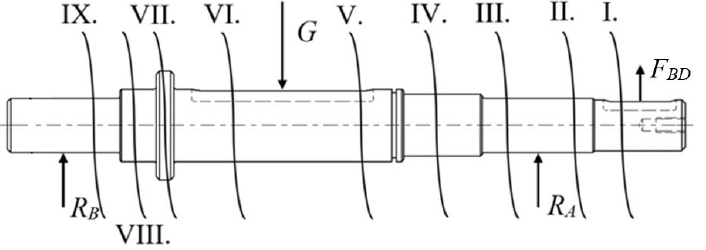
Figure 8. Loaded shaft with marked sections (Legend: G — heaviness, F BD — force from the belt drive, R A — reaction, R B — reaction, I. – IX. — marked sections). R A —reaction, R B —reaction, I.–IX.—marked sections).